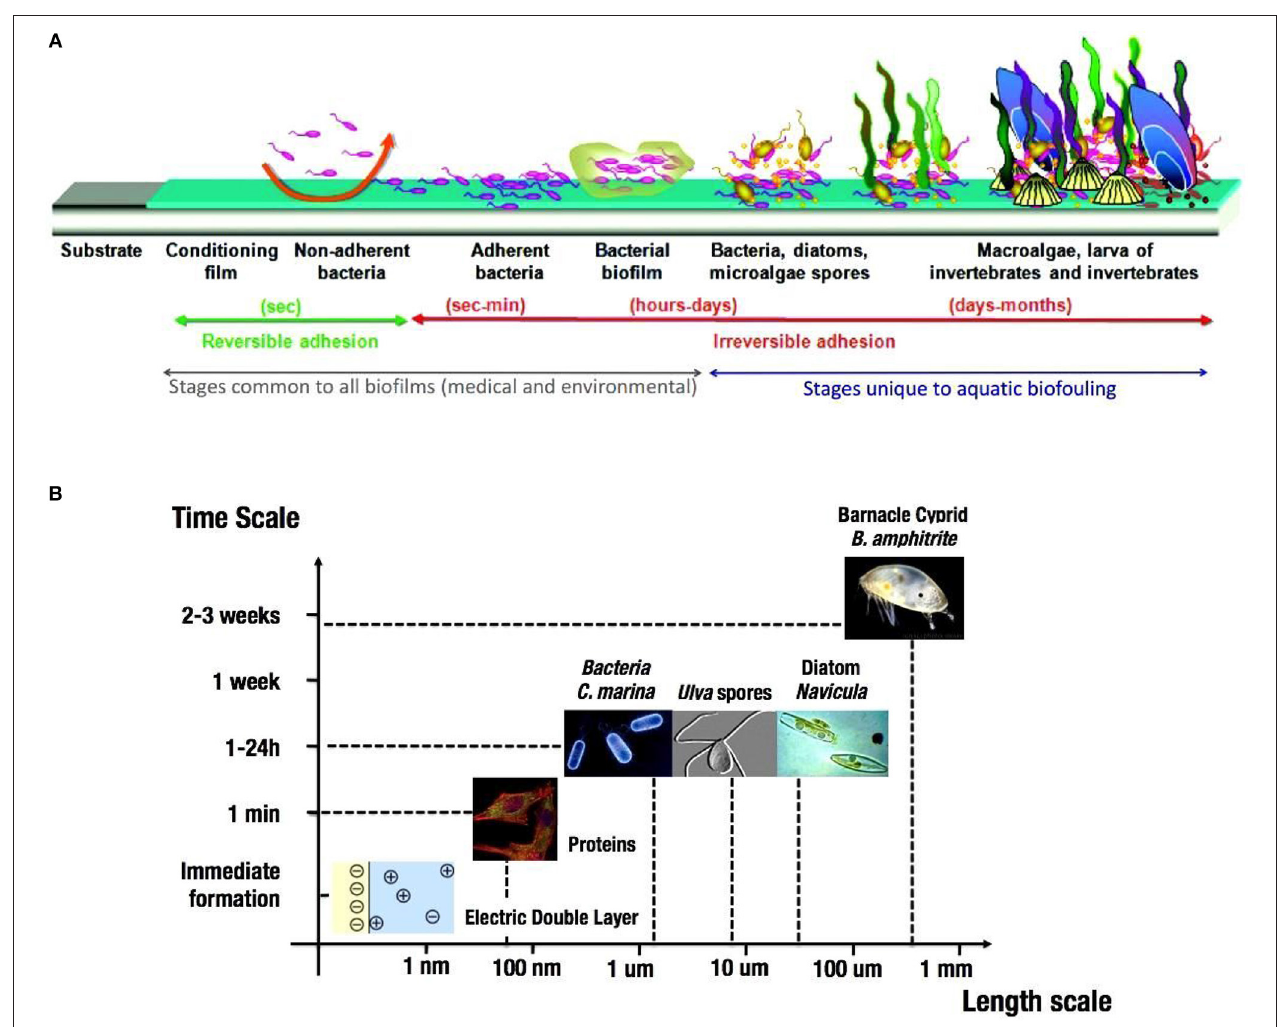
FIGURE 1 | (A) Stages of biofilm formation (modified after Rubio, 2002). (B) Characteristic time of biofilm formation vs. length scale of organism’s colony (data taken from Dang and Lovell, 2016).